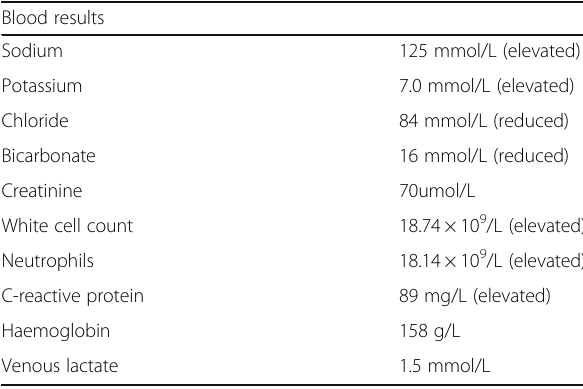
Table 1 Blood results on the day of the patient ’ s final presentation Blood